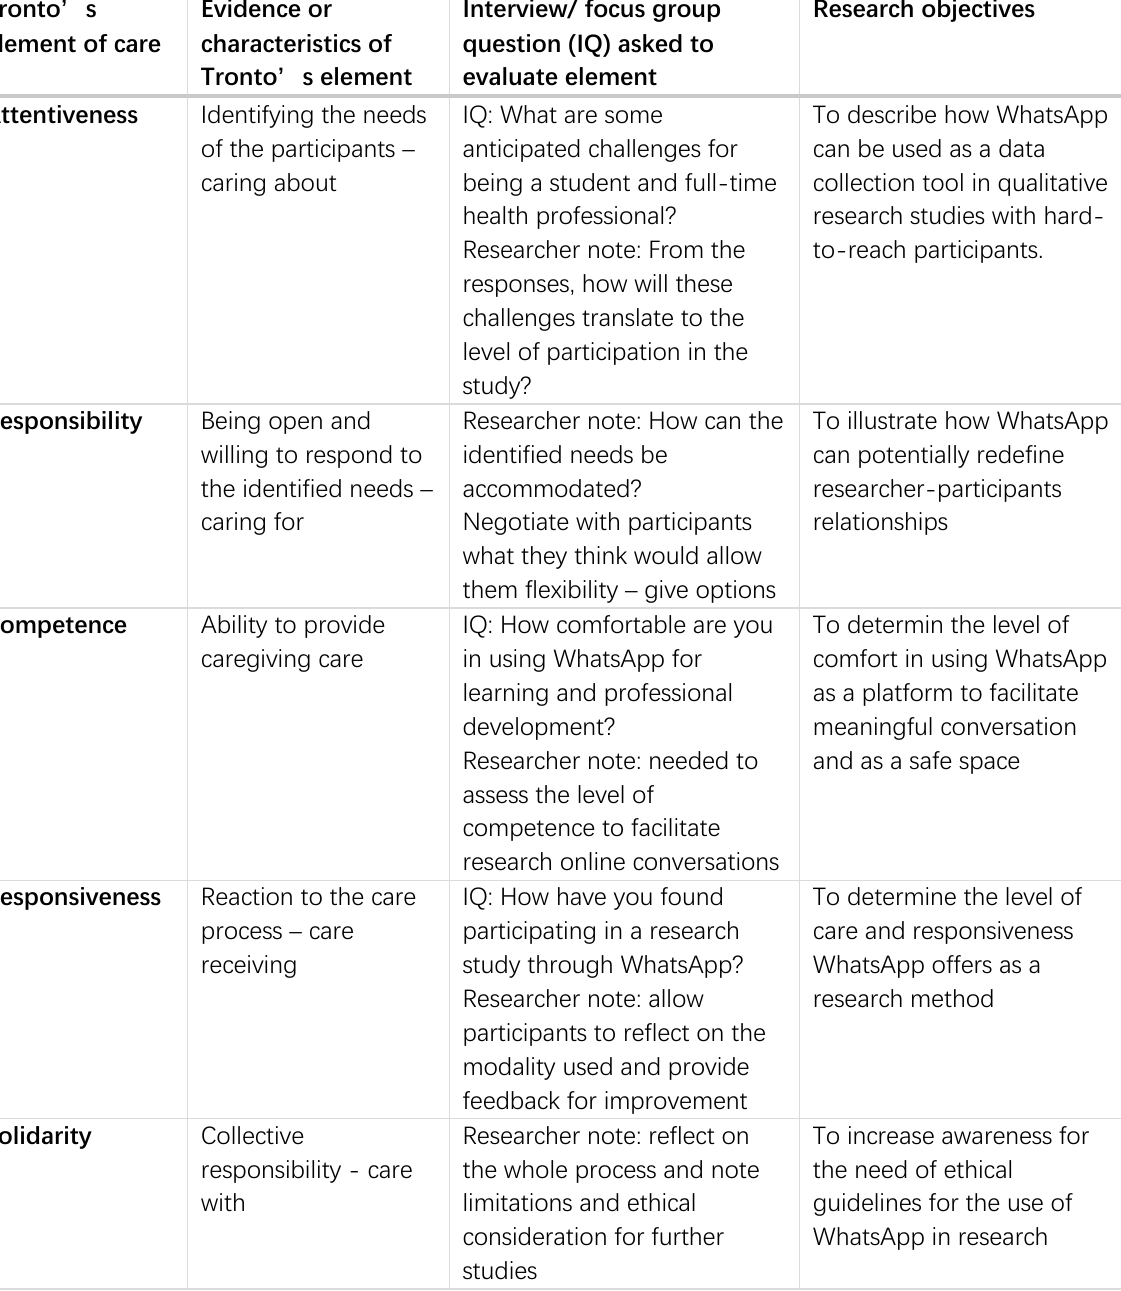
Table 1 : An analysis overview of illustarting the relationship of Tronto’s elements of care indicators, research questions and study